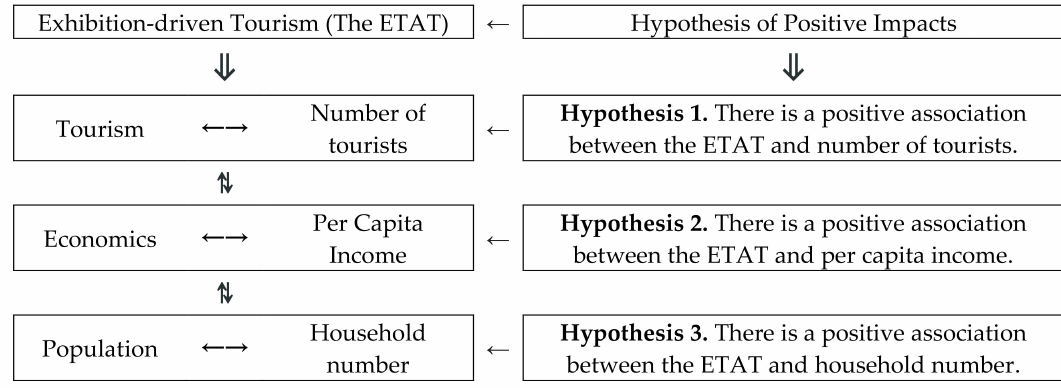
Figure 1. The logical